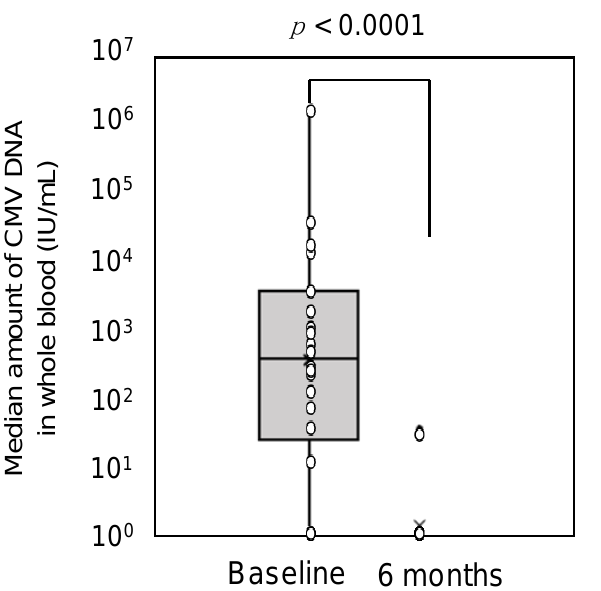
Figure 2. Cytomegalovirus loads in whole blood at baseline and after 6 months of treatment. CMV, cytomegalovirus. Table 2. Assessments of best ear and total ear hearing using auditory brainstem responses before and after 6 months of